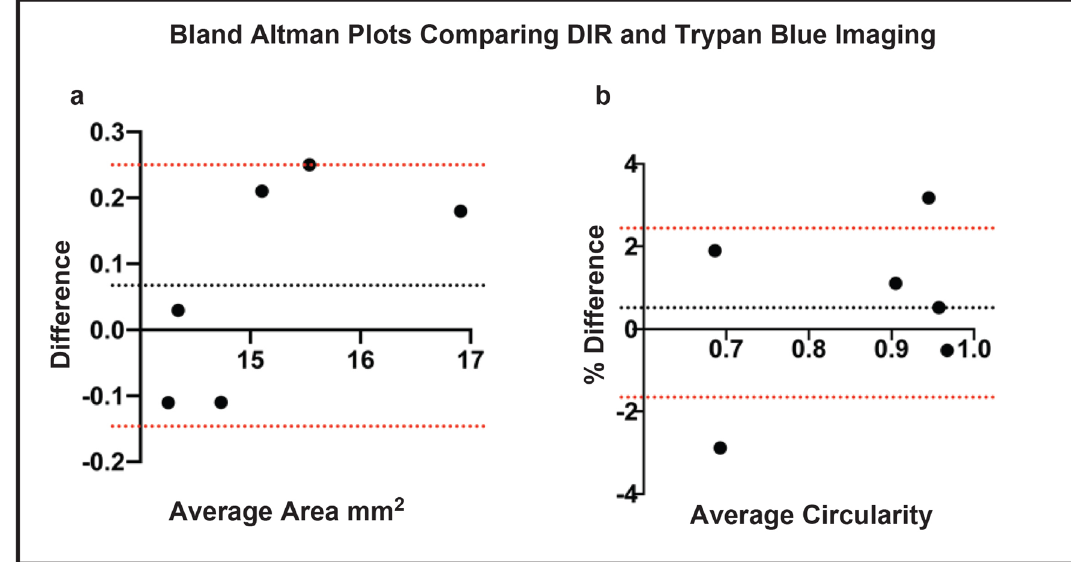
Figure 6. Bland–Altman Plots comparing in vivo wound size as assessed by DIR staining and intra-cameral trypan blue injection. Cornea endothelial wounds were measured using trypan blue and DIR in 6 eyes. The dotted black line represents the average bias, with the wound area measured by trypan blue tending to be marginally larger. The red dotted lines represent the 95% percent confidence interval. ( a ) Residual wound area as measured by DIR and trypan blue was within 0.3 mm for all samples. ( b ) Residual wound circularity as measured by DIR and trypan blue was within 4% for all individual